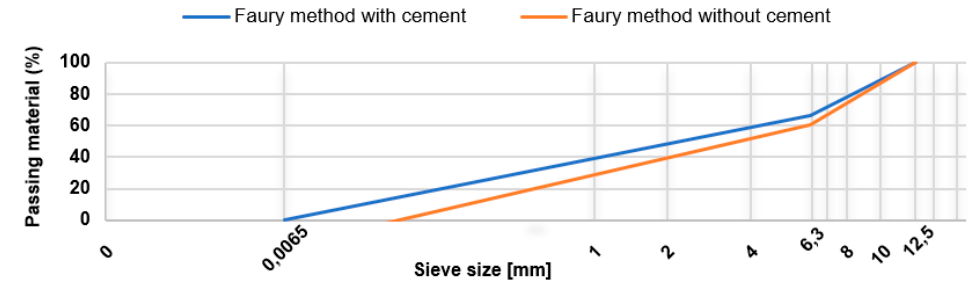
Figure 1. Faury method for reference concrete.